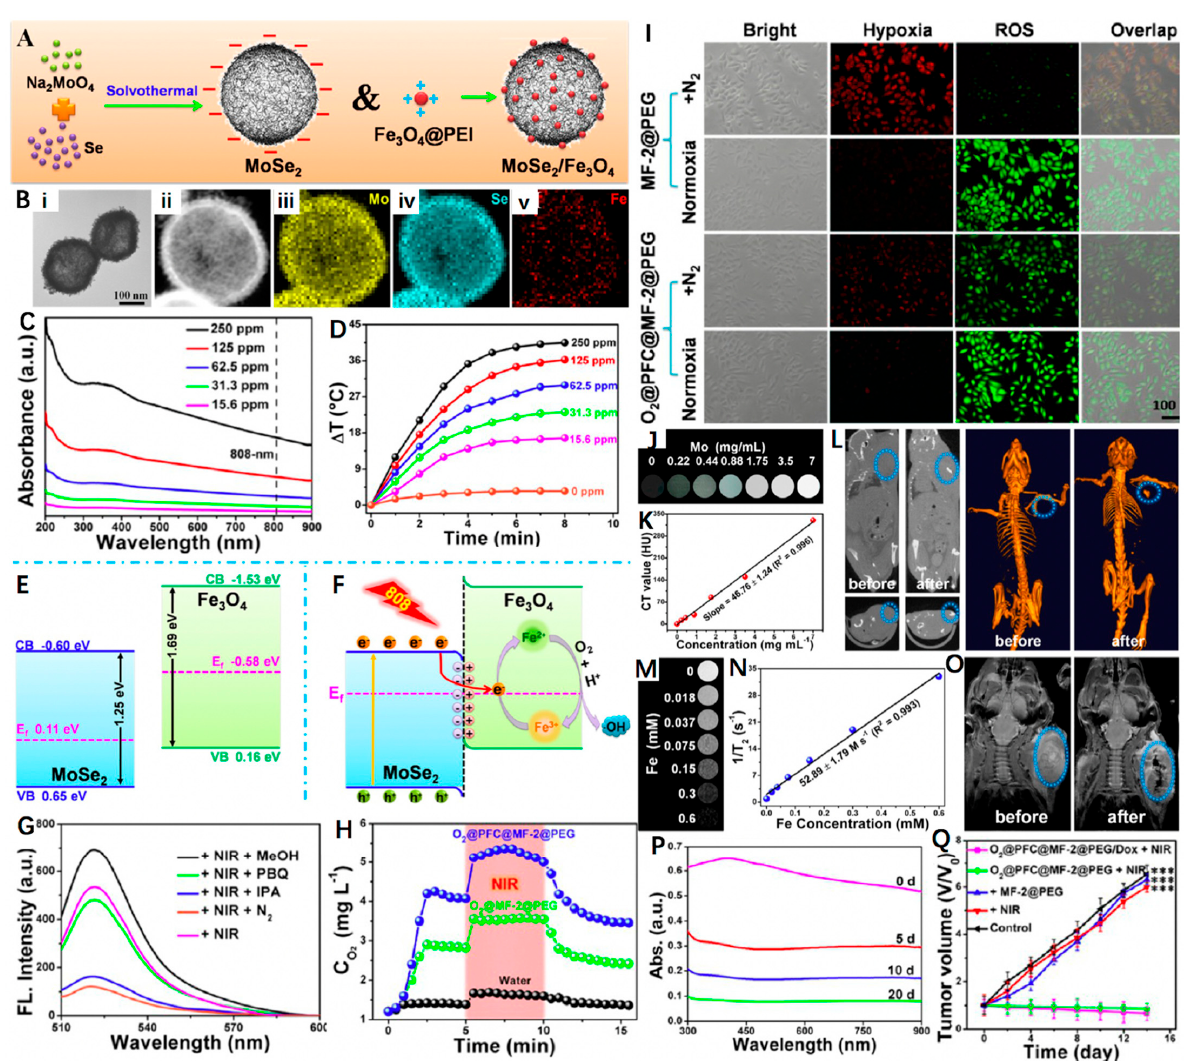
Figure 7. ( A ) Schematic representation of MoSe 2 and MoSe 2 /Fe 3 O 4 nanomaterials. ( B ) TEM image of MF-2 and HAADF − STEM image of MF-2 and the corresponding STEM − EDX elemental mapping images for Se, Mo, and Fe. ( C ) UV − Vis spectrum of MF-2 with different concentrations. ( D ) Photothermal heating curves of MF-2 dispersions with different concentrations under an 808 nm laser (1 W cm − 2 ) irradiation. ( E , F ) Schematic illustration of the energy band configuration of MoSe 2 and Fe 3 O 4 and possible mechanism of the charge separation of the MoSe 2 /Fe 3 O 4 system. ( G ) Fluorescence spectra (excitation at 495 nm) of corresponding sample supernatants (300 μ g mL − 1 ) and DCFH-DA after irradiation by a NIR laser for 10 min (808 nm, 1 W cm − 2 ) under different conditions. ( H ) O 2 concentration changes after the addition of O 2 @MF-2@PEG or O 2 @PFC@MF-2@PEG into deoxygenated water under without and with 808 nm laser irradiation. ( I ) Fluorescence images of the cells stained with ROS and hypoxia probes. ( J , K ) In vitro CT images and relative CT values of MF-2 solution vs. different Mo concentrations. ( L ) CT images of a tumor-bearing mouse before and after injection in situ. ( M , N ) T 2 -weighted MR images and corresponding relaxation rates (r 2 ) of MF-2 recorded using a 9.4 T MR scanner. ( O ) MR images for in vivo mapping before and after injection of MF-2@PEG. ( P ) Degradation time-dependent UV − Vis spectra of MF-2 in PBS. ( Q ) Changes in the relative tumor volume achieved after various treatments. Reprinted with permission from Ref. [108]. Copyright 2019, American Chemical Society. *** p < 0.001.